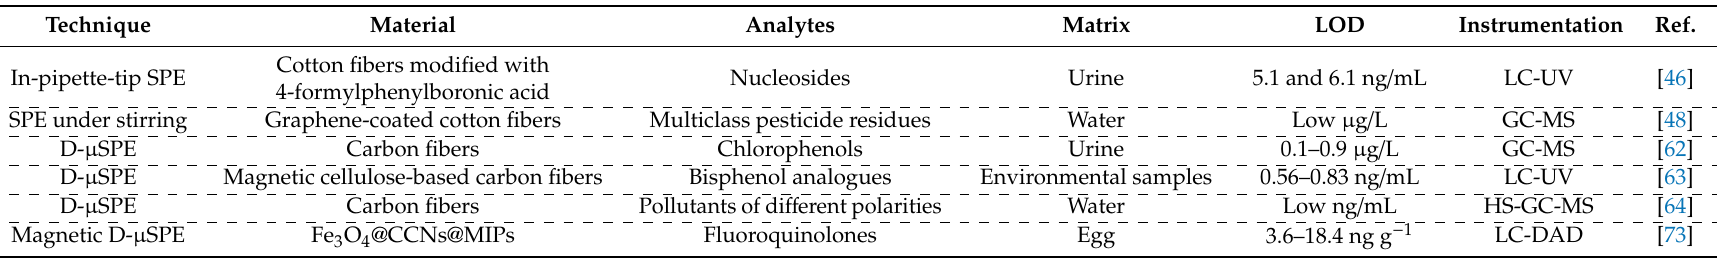
Table 2. Applications of cotton as sorbent material in microextraction techniques for di ff erent analytes and matrices. (Reference period: